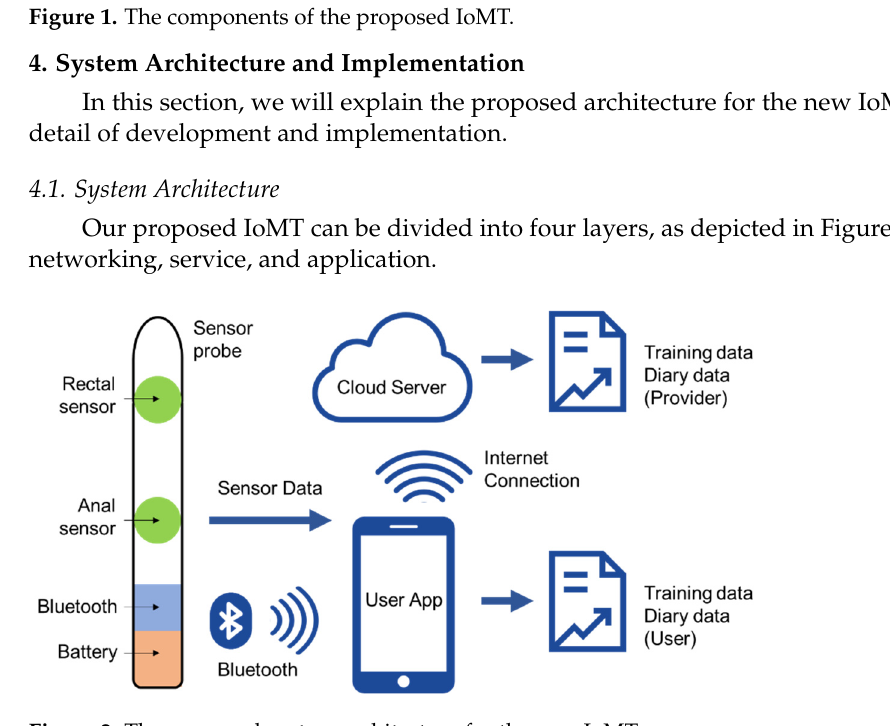
Figure 1. The components of the proposed IoMT.